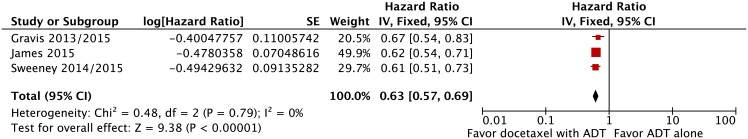
Comparative effect in biochemical progression-free survival of ADT with docetaxel versus ADT alone.Abbreviations: ADT, androgen-deprivation therapy; CI, confidence interval.